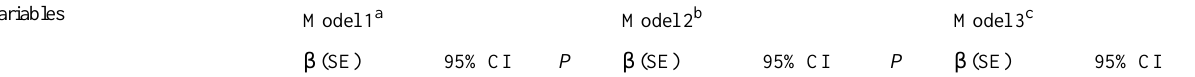
Table 7. Ordinal logistic regression: association between online health information–seeking behaviors and hypertension medication adherence